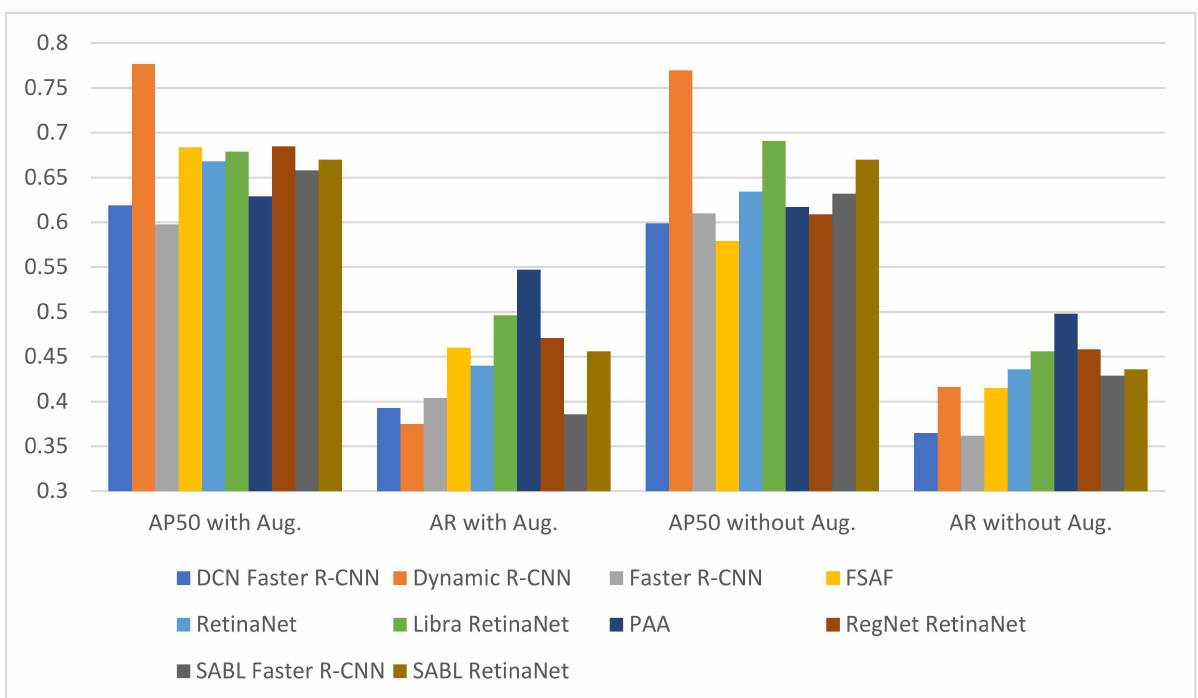
Figure 13. Validation AP50 and AR results of detection models.